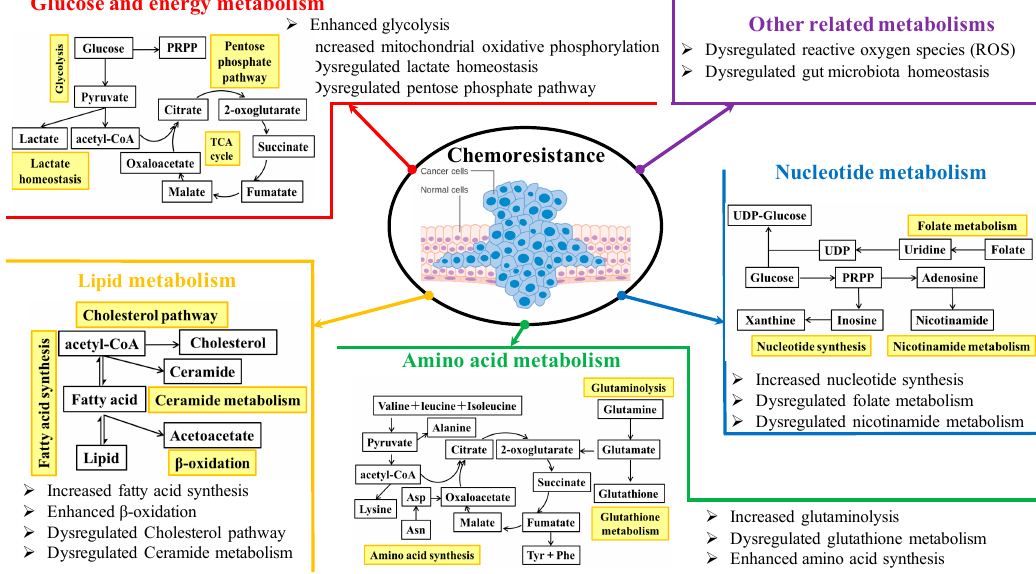
Figure 1. An overview of chemoresistance modulated by metabolic reprogramming in cancer cells